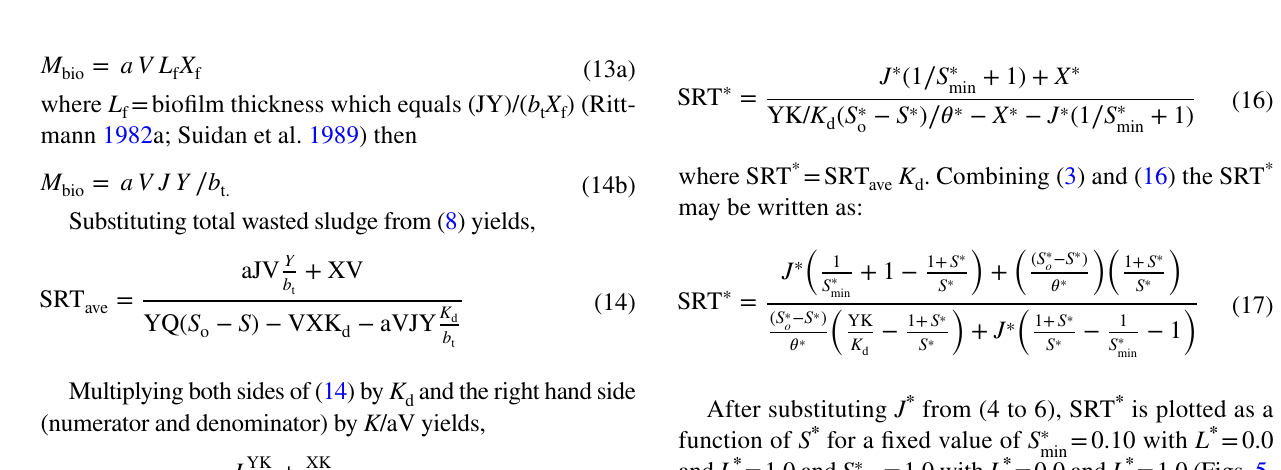
Fig. 3 (Qw Xu) * as a function of S * and ( S ∗ o − S )/HRT at Y K / K L * = 1.0, S ∗ min =